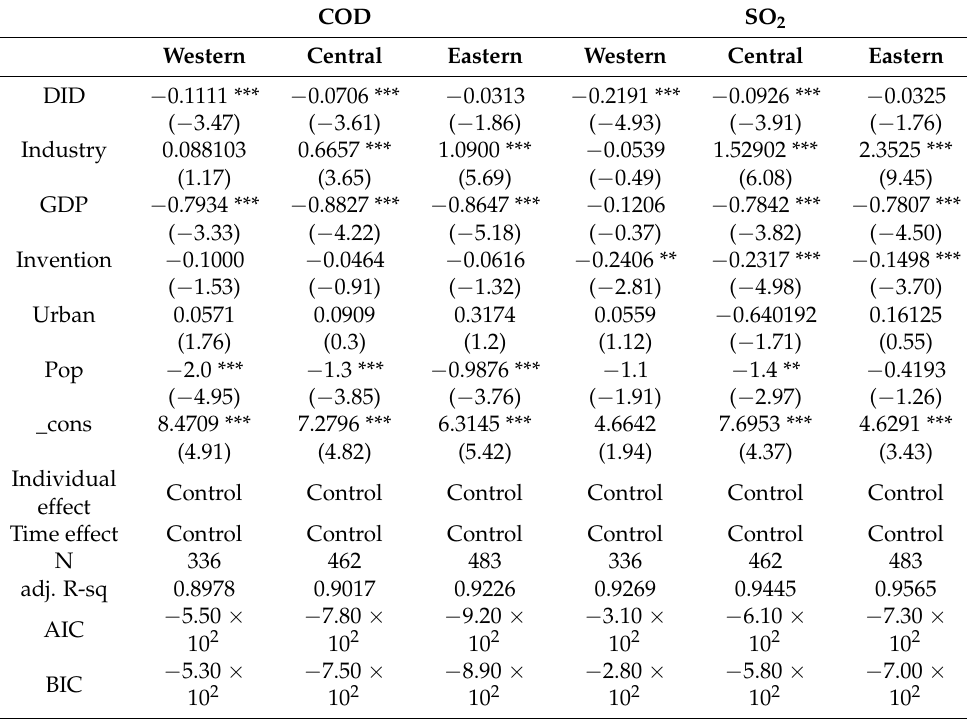
Table 6. Comparison of EP policy effects in different regions.